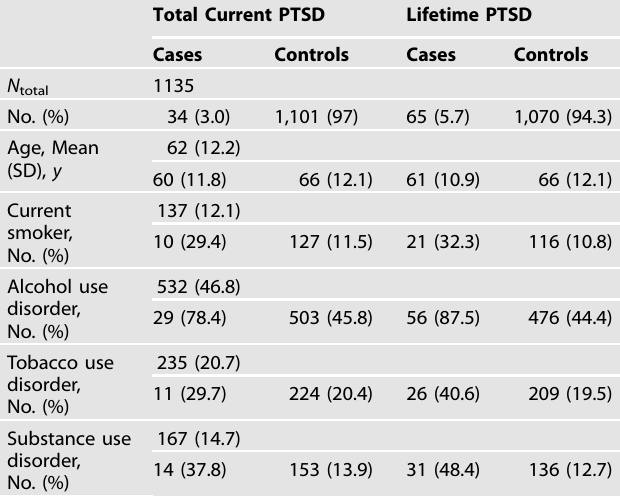
Table 2. Demographic and clinical characteristics of the European – American male veteran study cohort ( n =